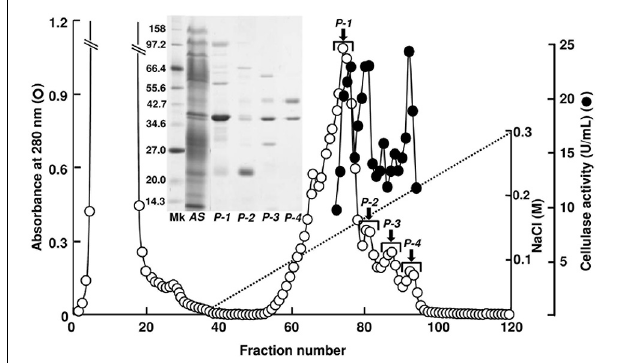
FIGURE 1 | TOYOPEARL CM-650M column chromatography for A. kurodai cellulase. Proteins precipitated between 40 and 60% saturation of ammonium sulfate from the crude enzyme was applied to a TOYOPEARL CM-650M column (1 . 5 × 20cm) and eluted with a linear gradient of 0–0.3M NaCl in 10mM sodium phosphate buffer (pH 7.0) at a flow rate of 15mL/h. Each fraction contains 7.0mL. SDS-PAGE of the peak fractions are shown in the inset.